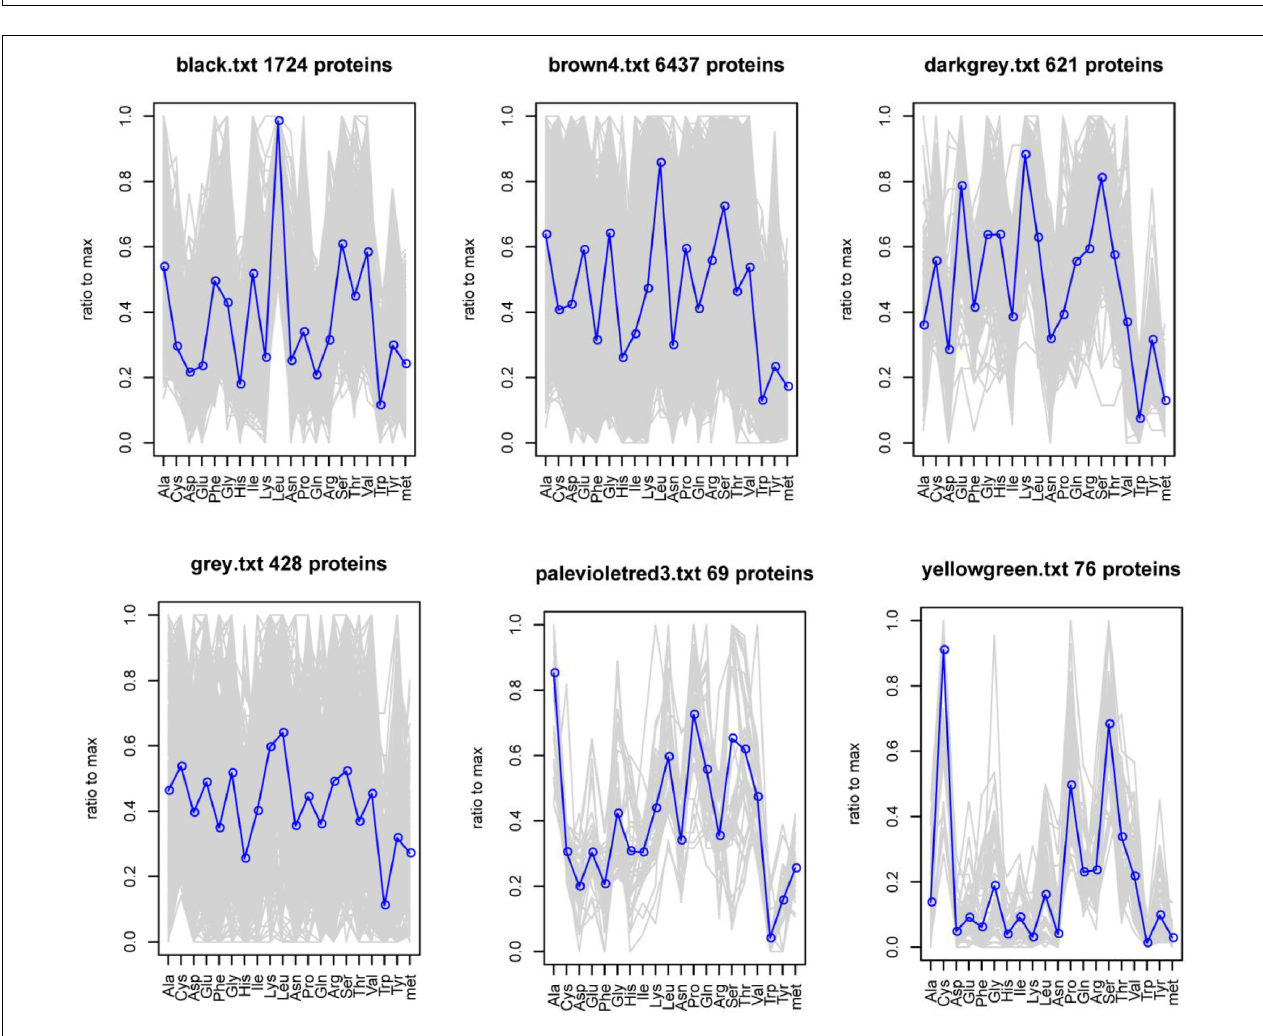
FIGURE 5 | FPKM of high-sulfur protein genes over the 12 study months. Abscissa represents month, and ordinate represents FPKM. D represents the control group.